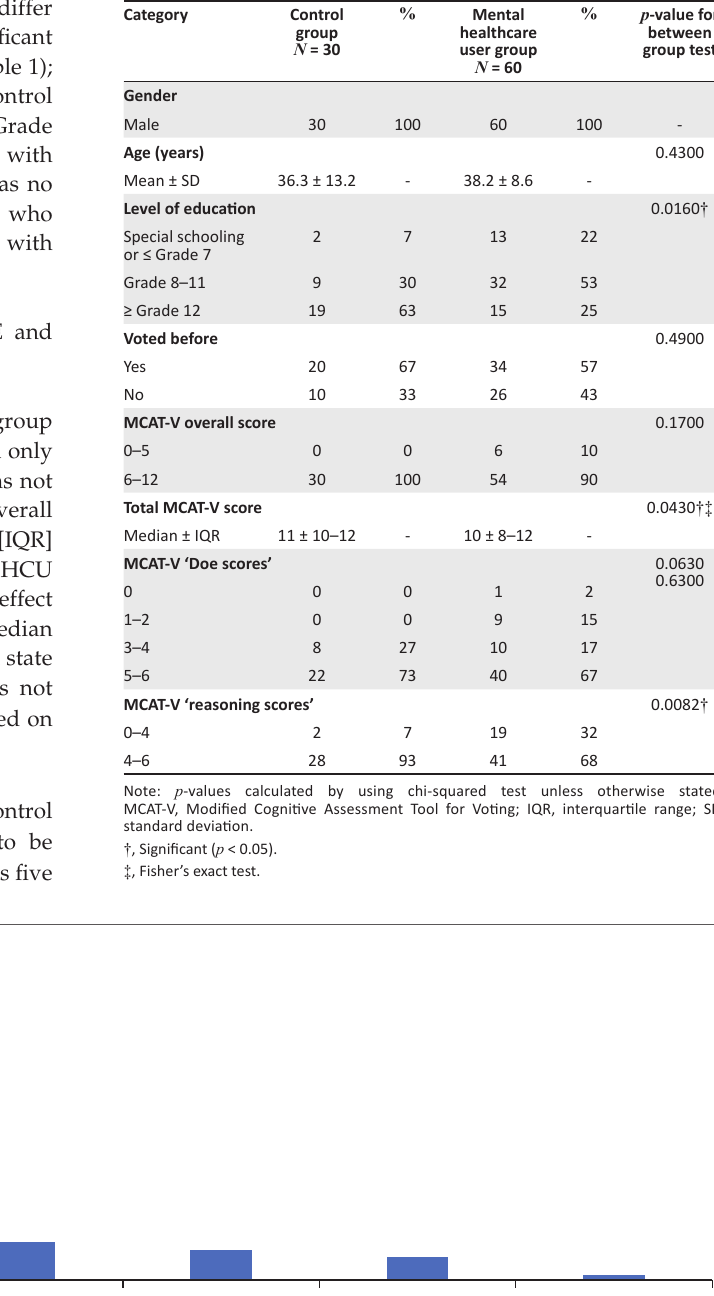
with the control group (93 % ) (Table 1). TABLE 1: Comparison of demographic and clinical data in the control group versus mental healthcare